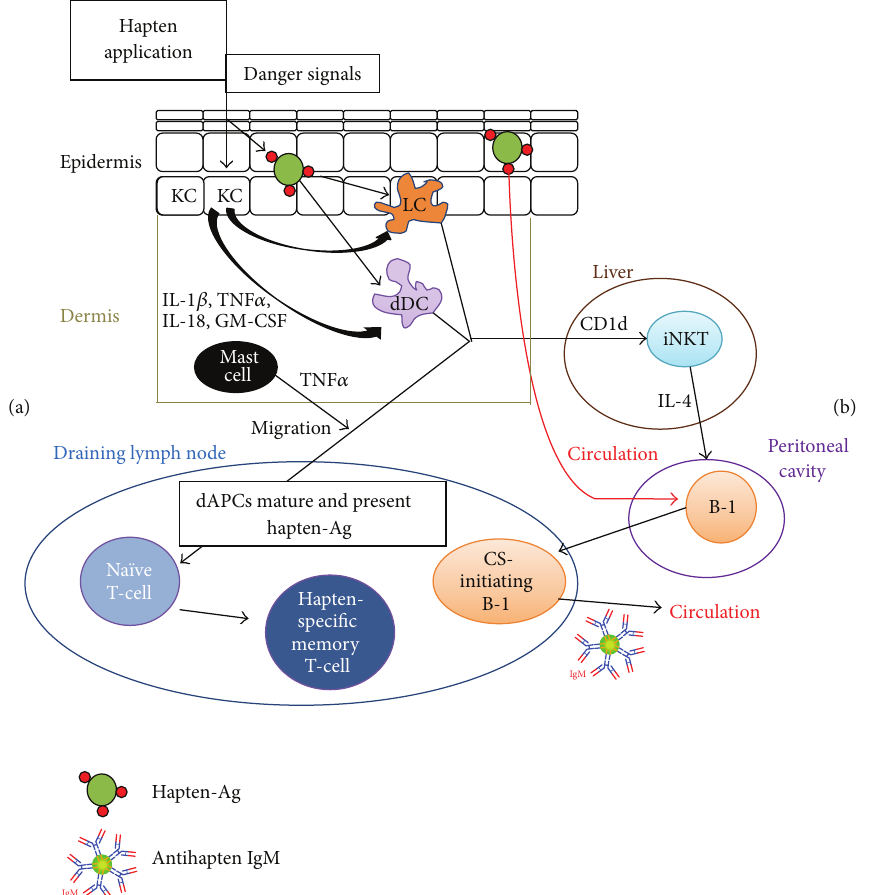
Figure 1: The likely pathway of the “sensitization” phase of contact hypersensitivity. (a) Hapten application induces strong innate immune mechanisms, causing cell death and the release of danger signals and endogenous ligands, leading to cytokine release, IL-1 𝛽 , IL-18, TNF 𝛼 , and GM-CSF, by keratinocytes (KC). This release will stimulate dermal antigen-presenting cells (dAPCs), langerhans cells, and dermal dendritic cells, to take up haptenated antigen and migrate to the dLN to activate na¨ıve T-cells. Mast cells will aid in this migration by releasing TNF 𝛼 . (b) iNKT cells in the liver will be activated by APCs presenting haptenated glycolipid by CD1d. This will cause cytokine release, IL-4, to stimulate na¨ıve B-1 cells in the peritoneal cavity, along with the binding of hapten-antigen by membrane IgM. This will cause migration of these cells to the dLN, and subsequent maturation into CS-initiating B-1 cells, which release antihapten IgM into